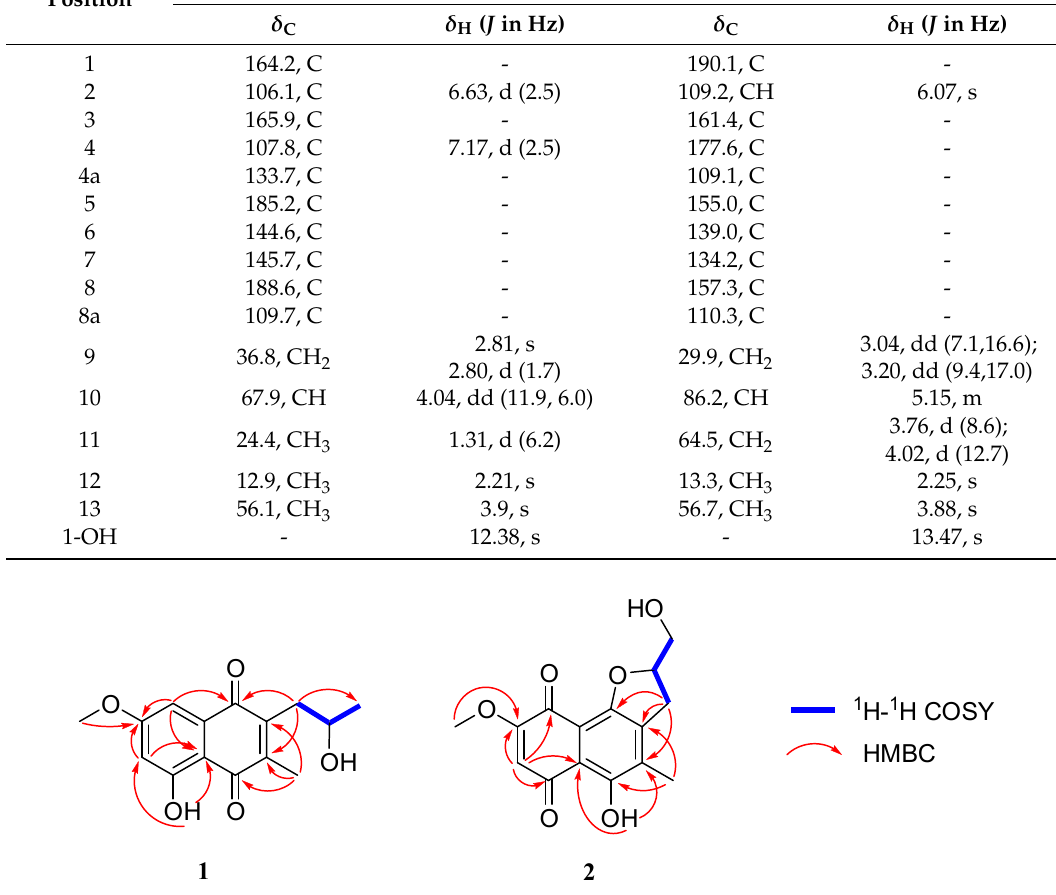
Figure 3. Calculated and experimental electronic circular dichroism (ECD) spectra of 1 . Talanaphthoquinone B ( 2 ) was isolated as a red solid with [ α ] 25 D : − 16.8 ( c 0.1, MeOH). The HRESIMS spectrum displayed a negative ion peak at m/z 307.08218 [M+H 2 O–H] – (calcd. for C 15 H 15 O 7 ,